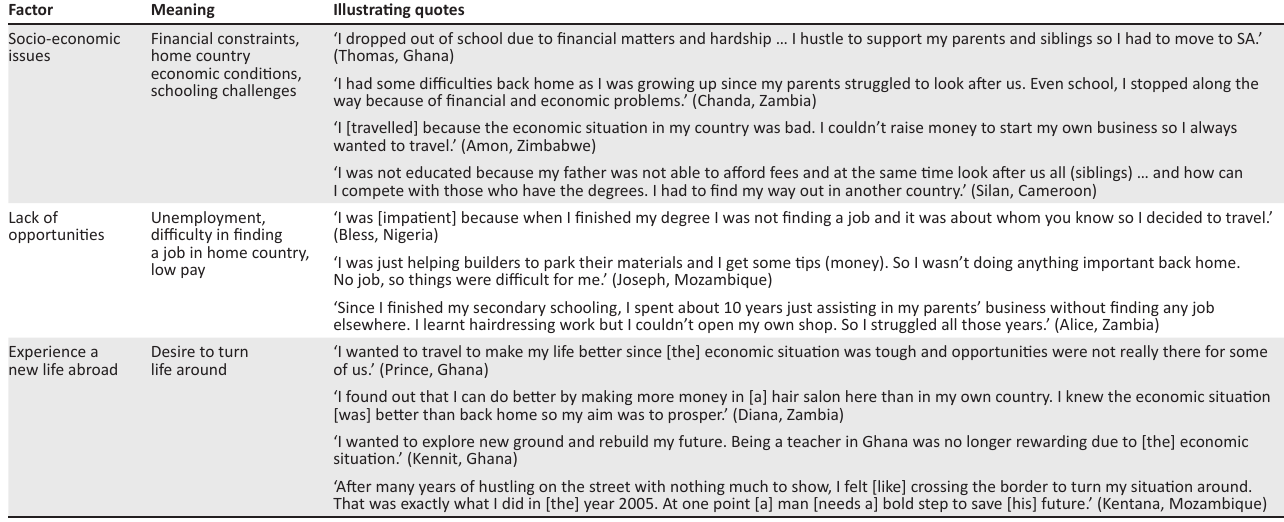
TABLE 3: Motivational factors for dirty work. Factors Meaning Illustrating quotes Document